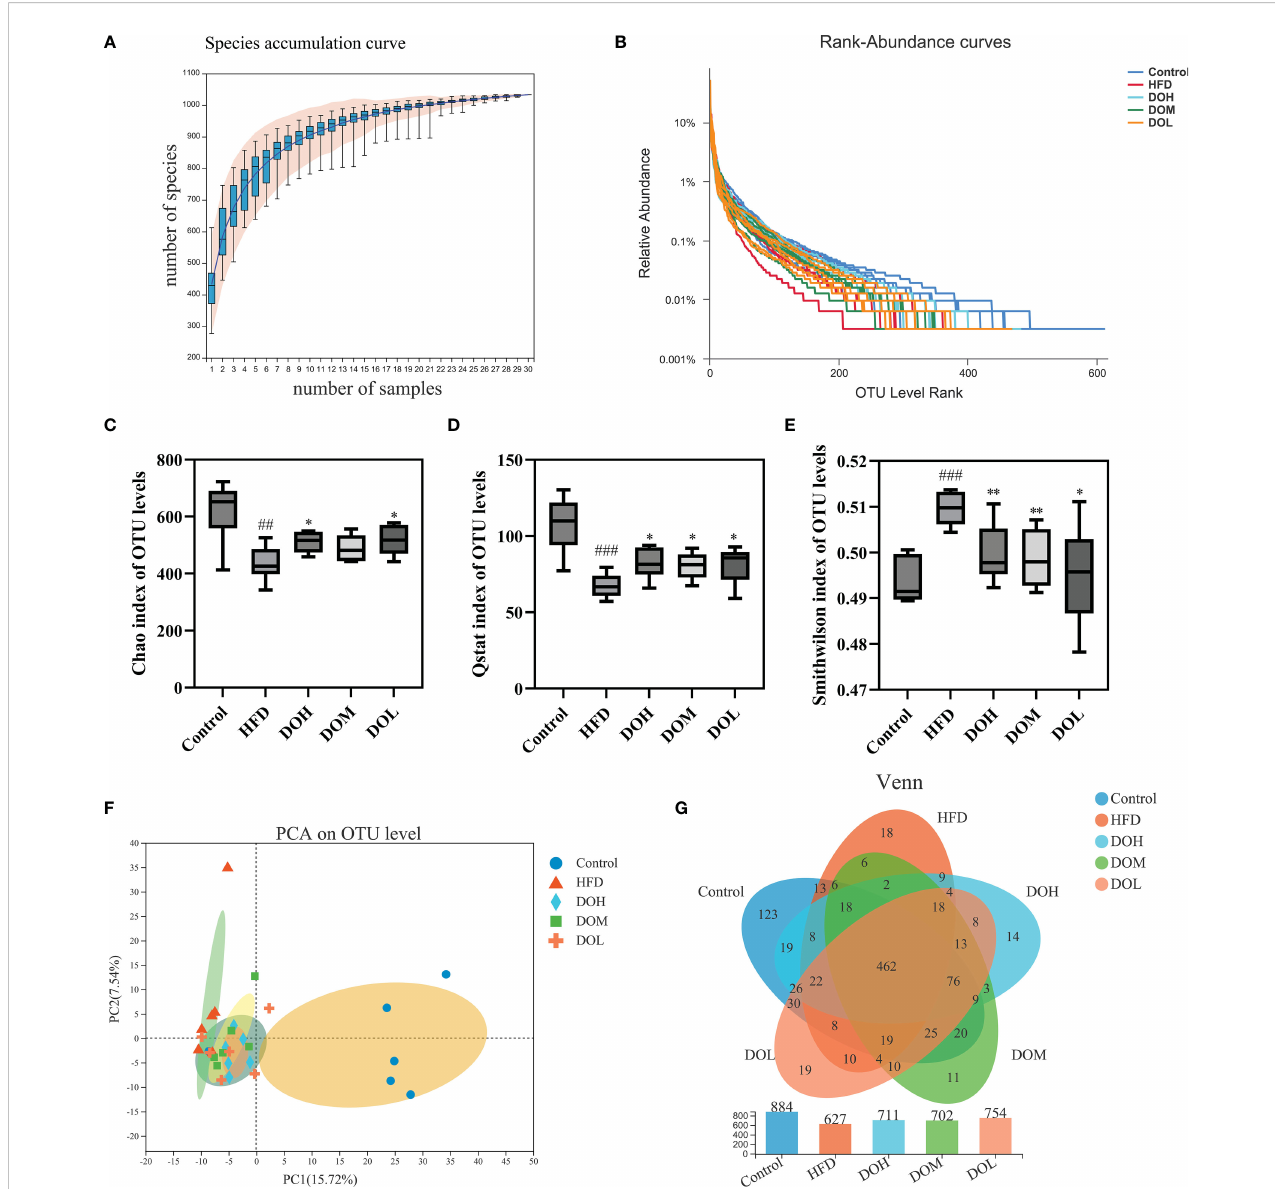
FIGURE 3 (A) Species accumulation curve; (B) rank-abundance curve; (C) Chao index by group; (D) Qstat index by group; (E) Smithwilson index by group; (F) PCA plot of microbial communities based on the OTU level. (G) Venn diagram based on the OTU level. Data are shown as the mean ± SD (n=6). ## p <